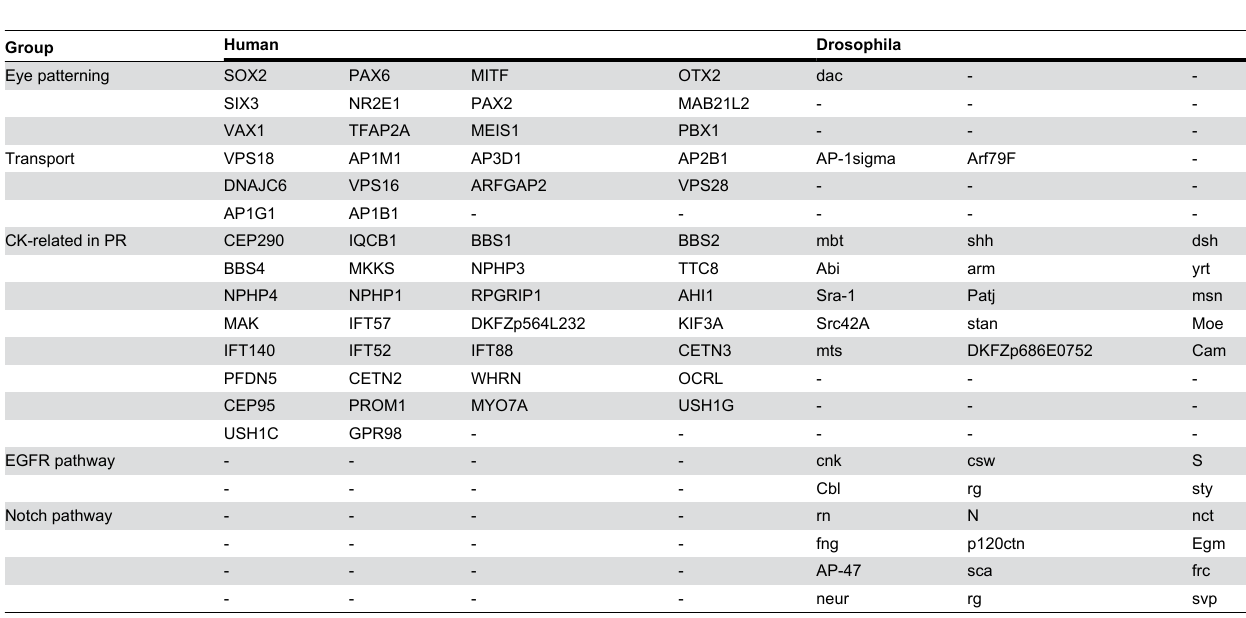
Table 1. Selected Nautilus or squid eye-related contigs having best hits with their Human or Drosophila homologues divided based on their